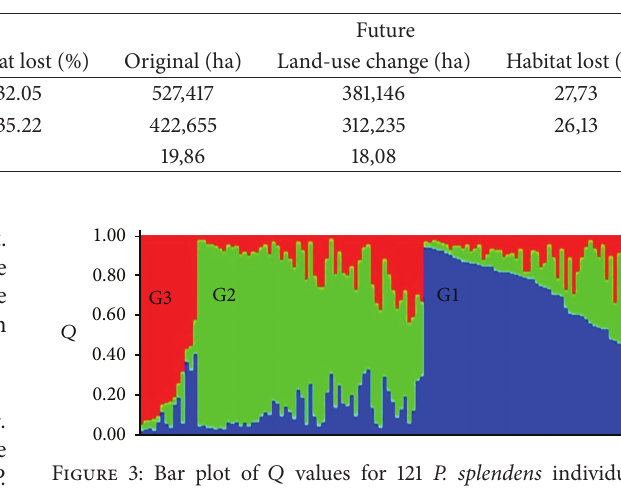
Table 3: Potential habitat, land-use change, and habitat loss of P. splendens under current climatic conditions (years 1950 to 2000) and future climate change scenario (RCP 6.0) (years 2041 to 2060) with different thresholds, maximum sensitivity plus specificity (MSS) and 10 percentile training presence (10PL).